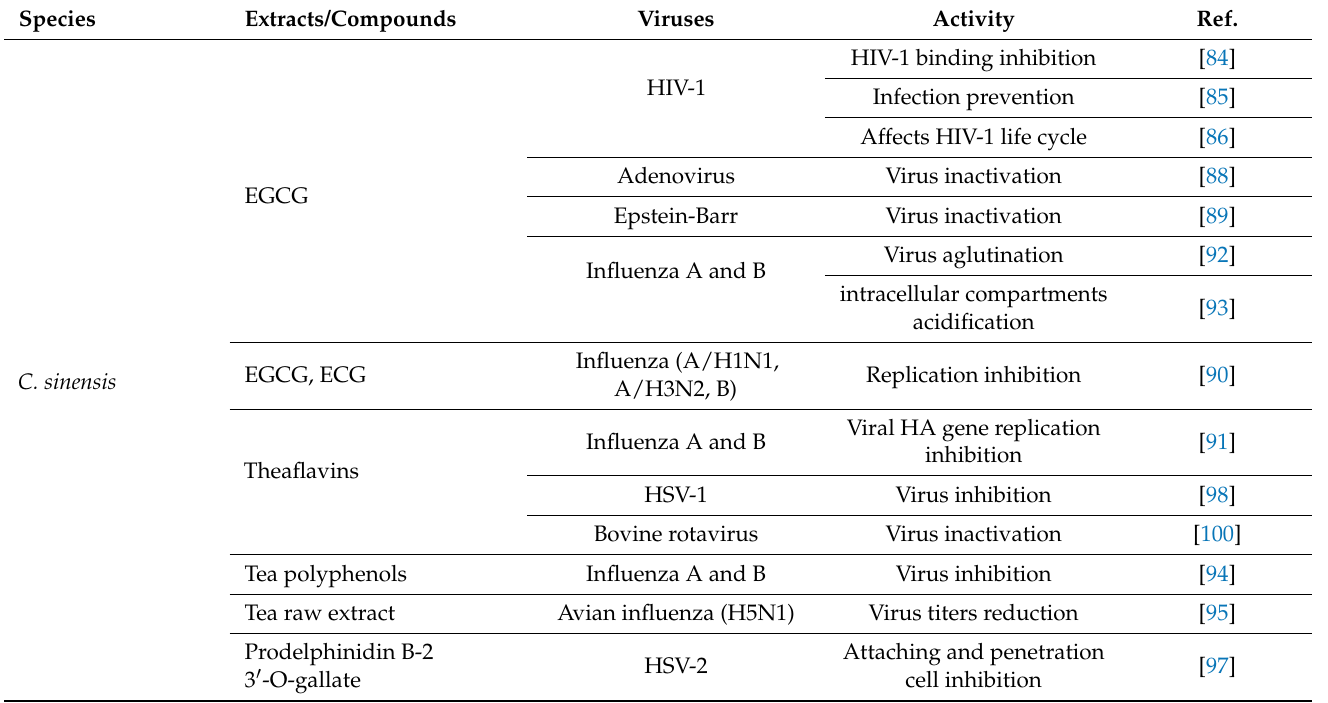
Table 3. Antiviral activity of Camellia